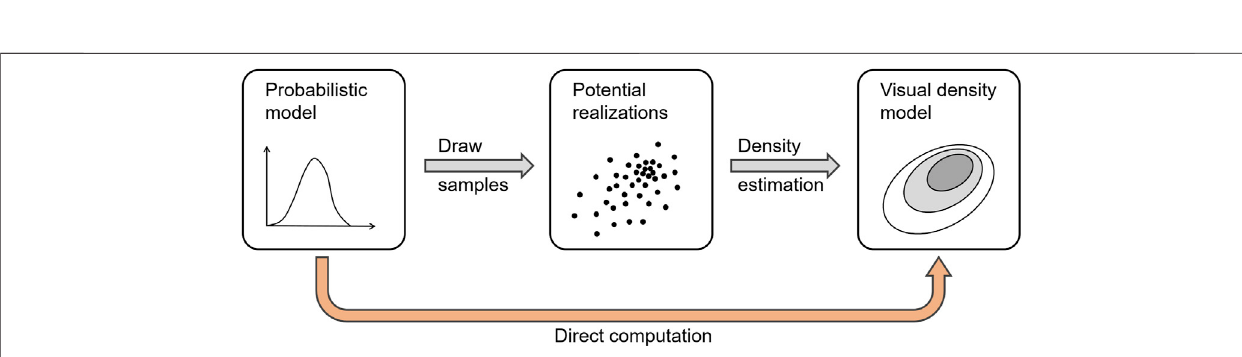
Frontiers in Bioinformatics |